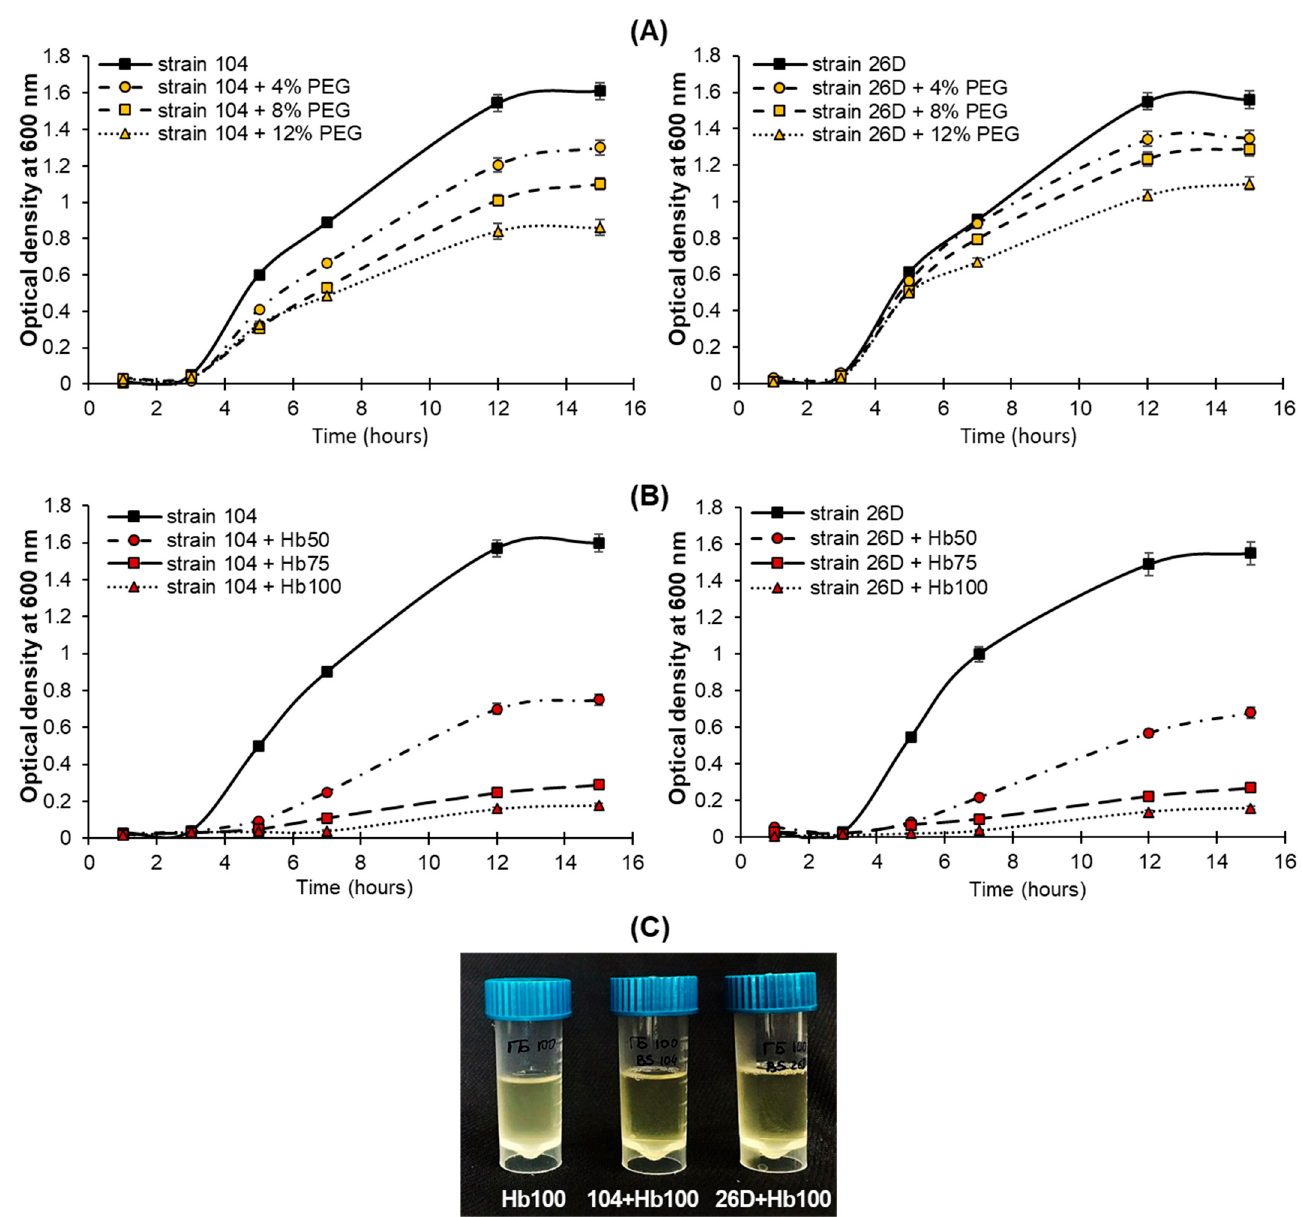
Figure 1. Growth curves of Bacillus subtilis strains 104 and 26D in control liquid Luria-Bertani (LB) medium and with the addition of herbicide Sekator ® Turbo (0.25 mL L − 1 (Hb50), 0.375 mL L − 1 (Hb75), and 0.5 mL L − 1 (Hb100)) ( A ) and PEG-6000 (4%, 8%, and 12%) ( B ); Photographs representing the ability of bacteria to clear the solution of LB medium containing 0.5 mL L − 1 herbicide (Hb100) after incubation for 24 h ( C ). The bacteria were incubated at 37 °C (180 rpm) for 24 h. The bacterial growth was monitored by measuring the optical density at 600 nm. Data were obtained in triplicate for each group. Error bars represent standard errors (±SE) of the means.